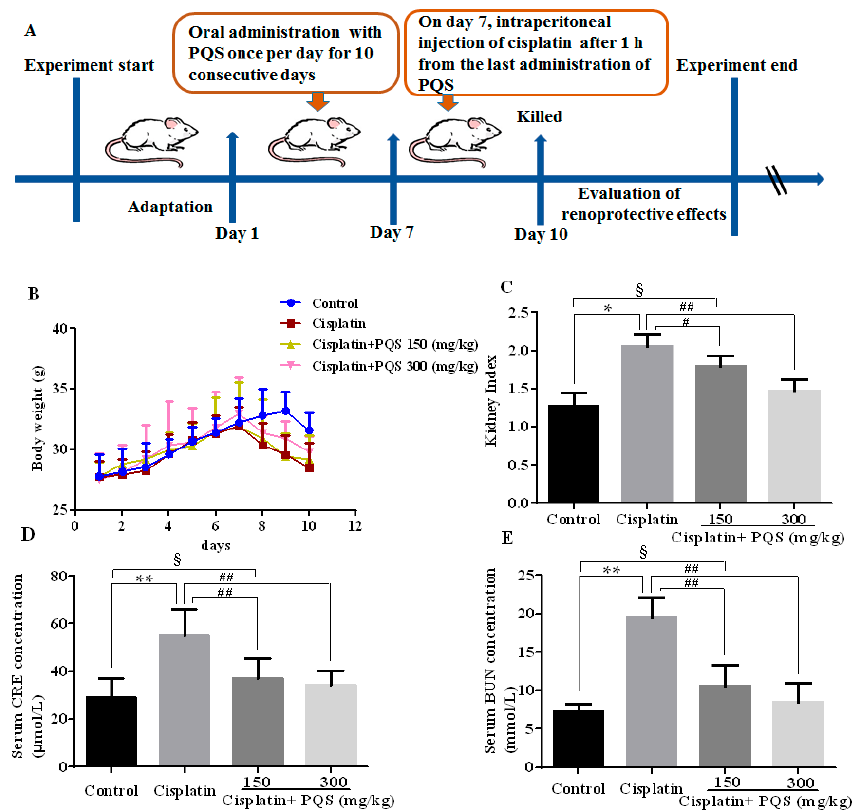
Figure 1. Experimental design of renoprotective effect of P. quinquefolius (PQS) on mice was